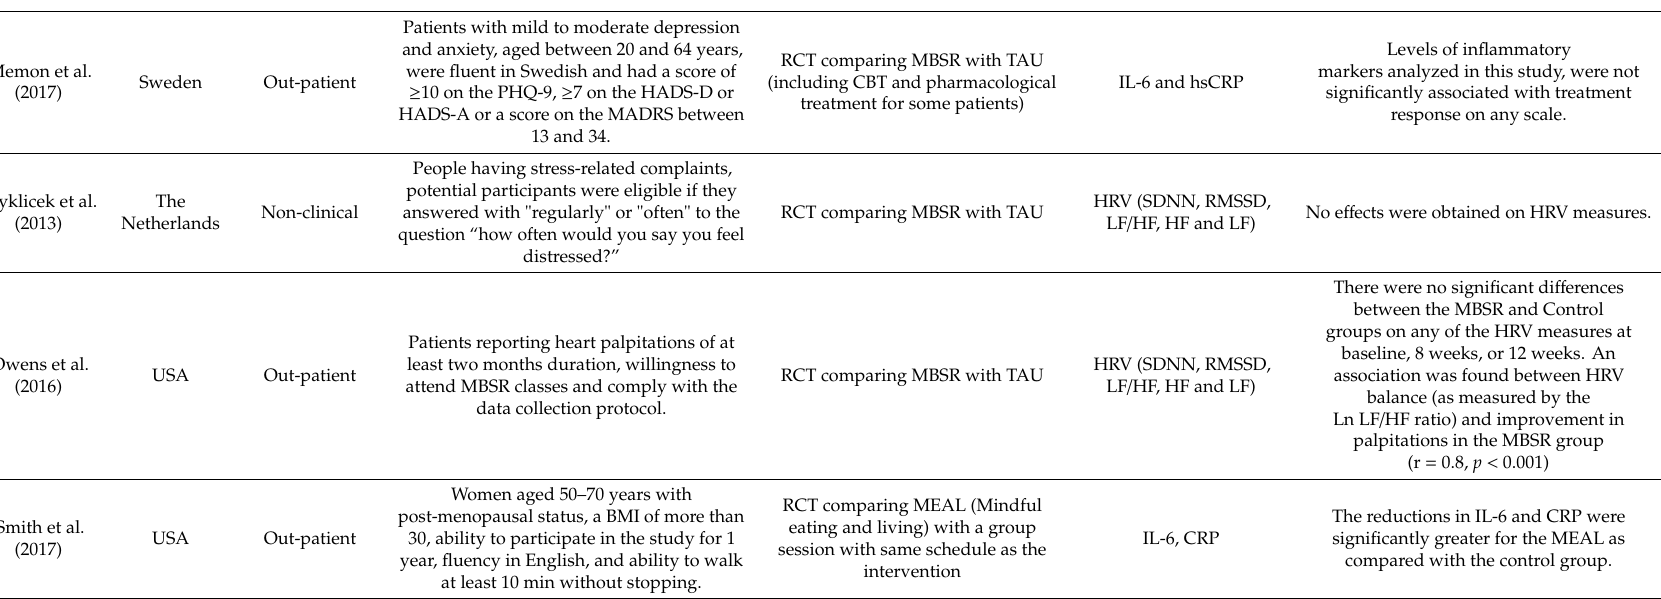
Table legend: Abbreviations: Randomised Controlled Trial (RCT); Mindfulness Based Stress Reduction (MBSR); Cognitive Behavioural Therapy (CBT); Treatment as usual (TAU); interleukin 6 (IL-6); C-reactive protein (CRP); high sensitivity (hsCRP); Heart Rate Variability (HRV); Low frequency (LF); High frequency (HF); standard deviations of